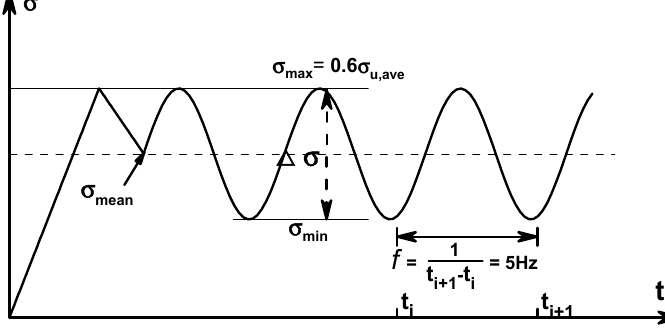
Figure 2. Loading procedure of the fatigue test.